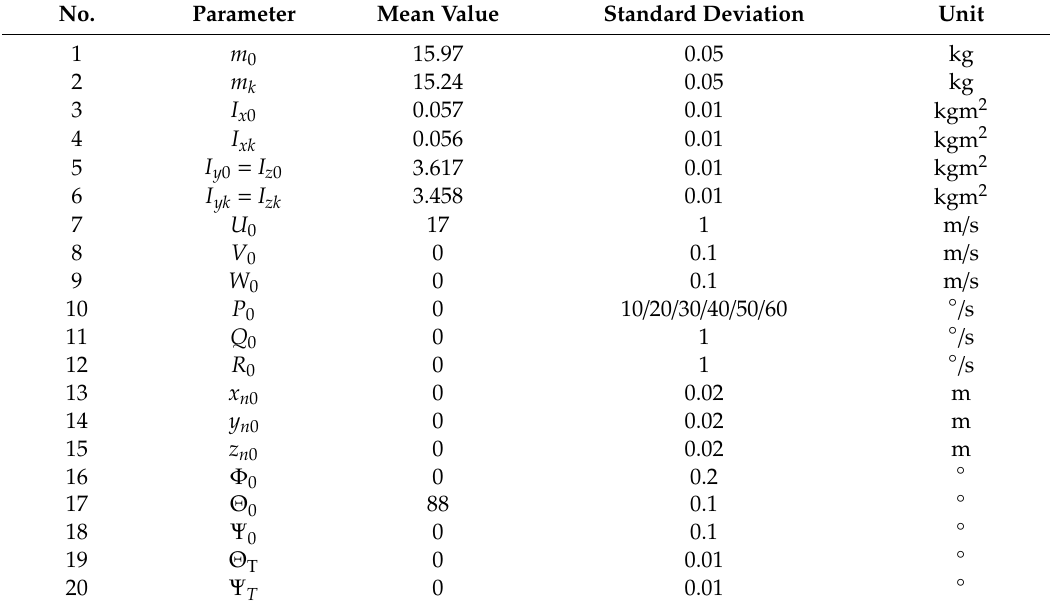
Table 1. Parameters for Monte-Carlo simulation (mass and launch